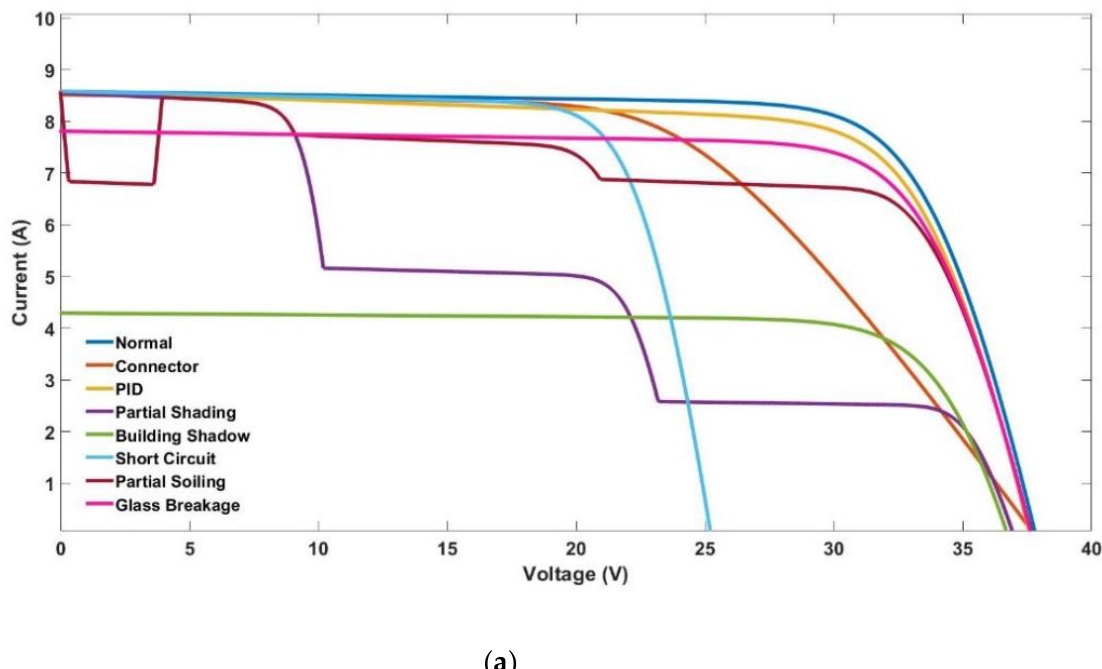
Figure 2. PV system simulation.